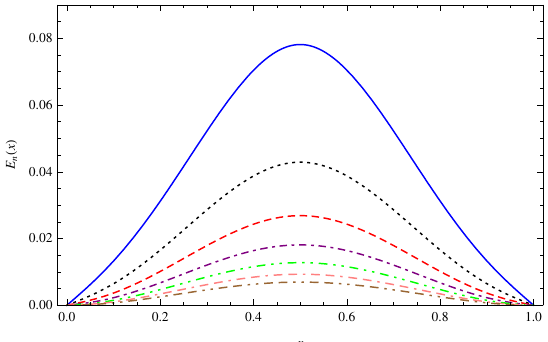
Figure 5: Curves of the error functions E n ( x ) for n = 3 (solid line), n = 4 (dot line), n = 5 (dashed line), n = 6 (dot-side line), n = 7 (dot-dot-side line), n = 8 (dot-side-side line), and n = 9 (dot-dot- side-side line) .